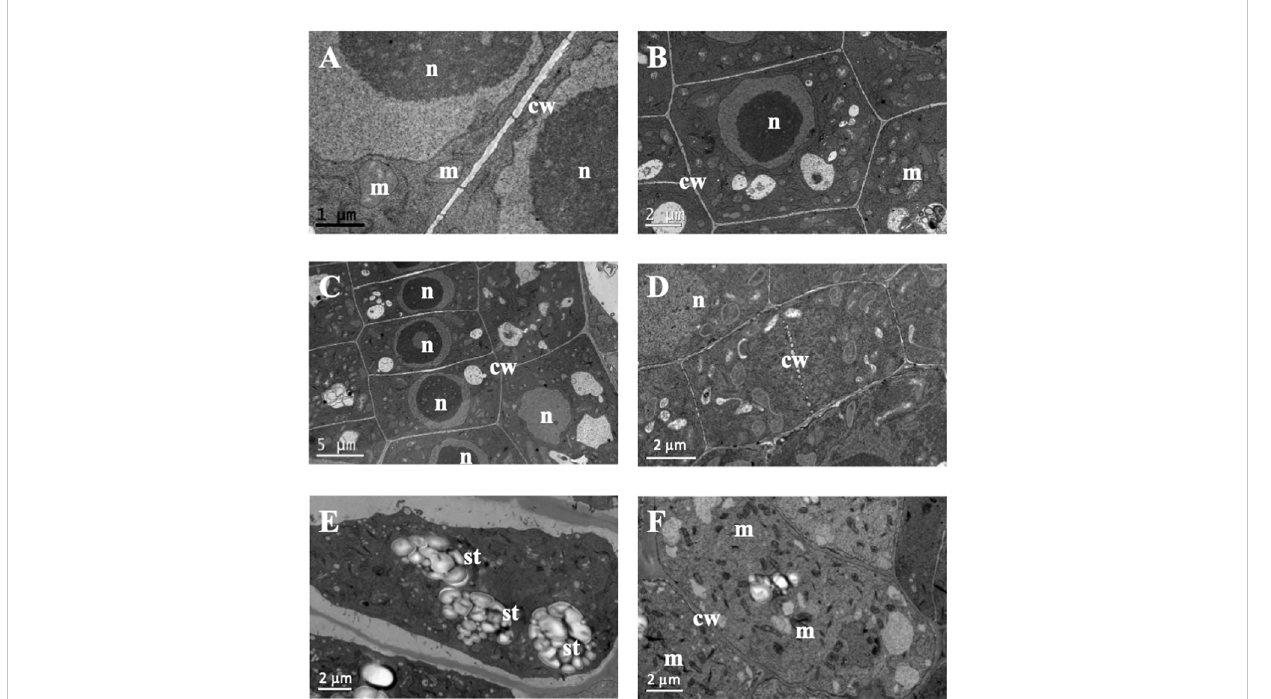
FIGURE 2 Images of transmission electron microscopy (TEM) of control Arabidopsis thaliana roots. (A) Straight cell wall separating two cells. (B, C) Symmetric control cells with spheric nuclei and regular cell walls. (D) Plant cell fi nishing dividing. (E) Statoliths in root cell. (F) Control cell with some mitochondria. (n, nucleus; m, mitochondria; cw, cell wall; st, statoliths). Scale bars: (A) 1 µm; (B – E) and (F) 2 µm; (C) 5